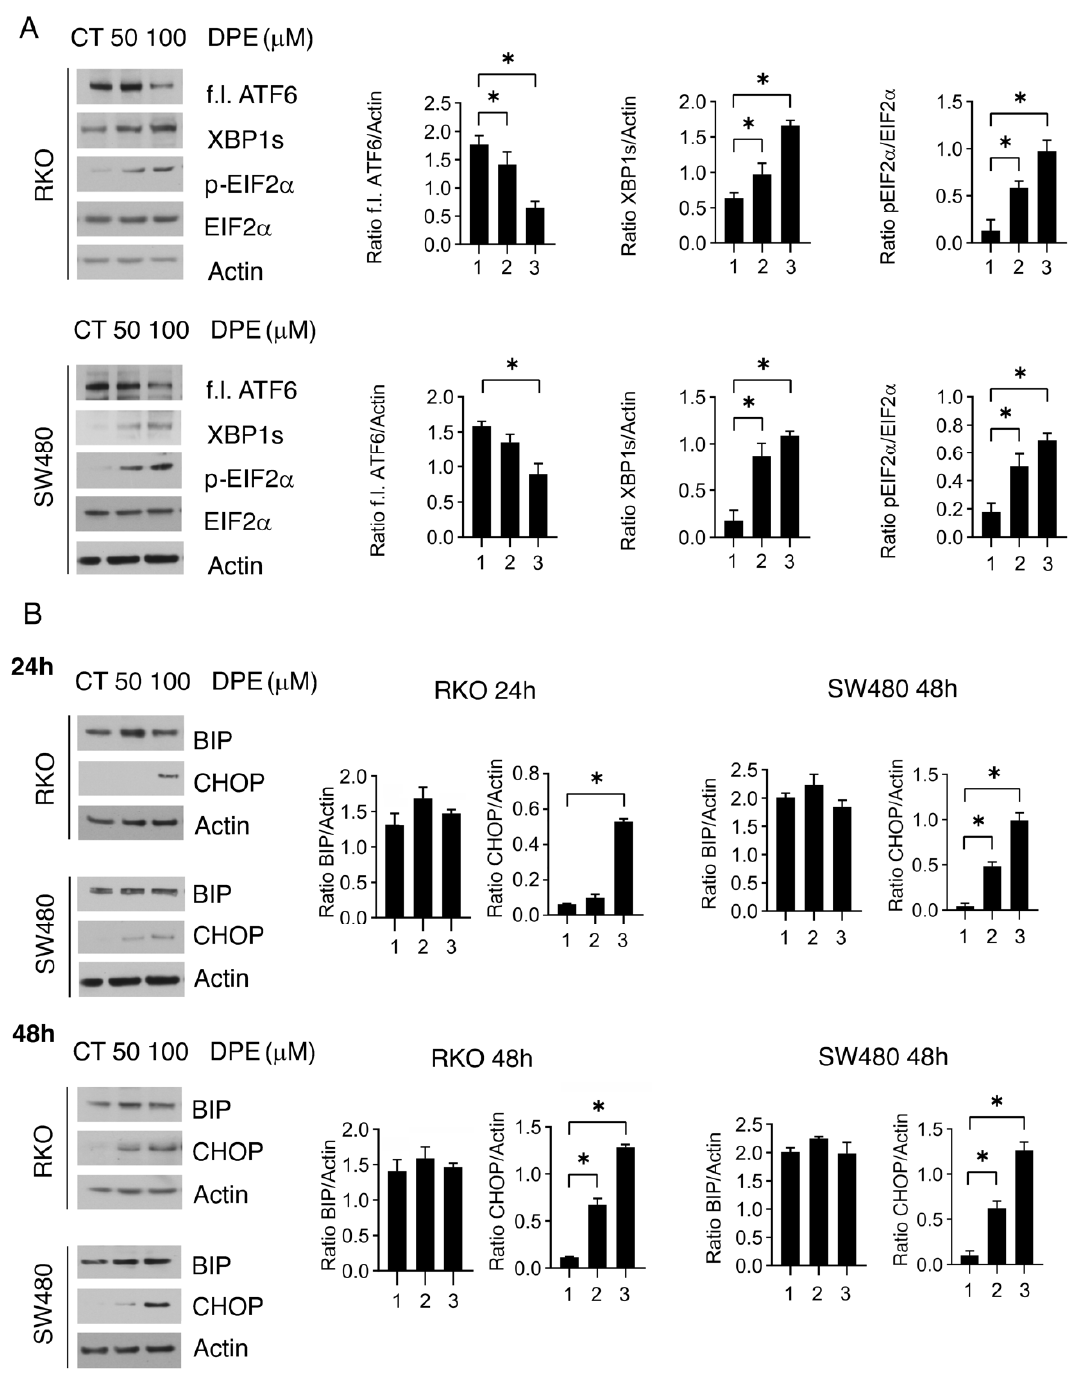
Figure 2. DPE induces ER stress and activates the pro-apoptotic transcription factor CHOP. ( A ) RKO and SW480 were treated with DPE (50 or 100 µ M) or left untreated as control. After 24 h of treatment, the expression levels of ATF6, XBP1s, p-EIF2a, and EIF2a were evaluated via Western blot analysis. β -Actin was used as the loading control. The histograms represent the means plus S.D. from the densitometric analysis of the ratio between the protein and the appropriate control. Note: * p < 0.05. ( B ) Expression levels of BiP and CHOP were evaluated via Western blot analysis after 24 or 48 h of treatment with DPE (50 or 100 µ M) or control. β -Actin was used as the loading control. The histograms represent the means plus S.D. from the densitometric analysis of the ratio between the protein and β -actin. Note: * p <